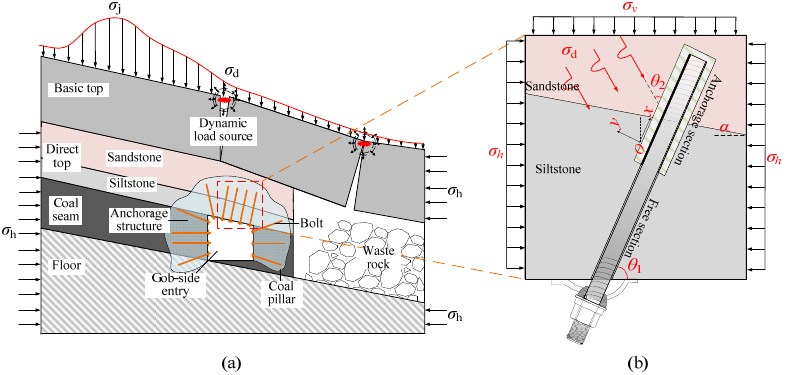
Figure 3. Stress environment of the surrounding rock and mechanical model of anchored bedding rock material. ( a ) Anchorage structure and stress environment of layered composite surrounding rock in Inclined Mining Roadway; ( b ) Mechanical model of anchorage bedding rock mass.